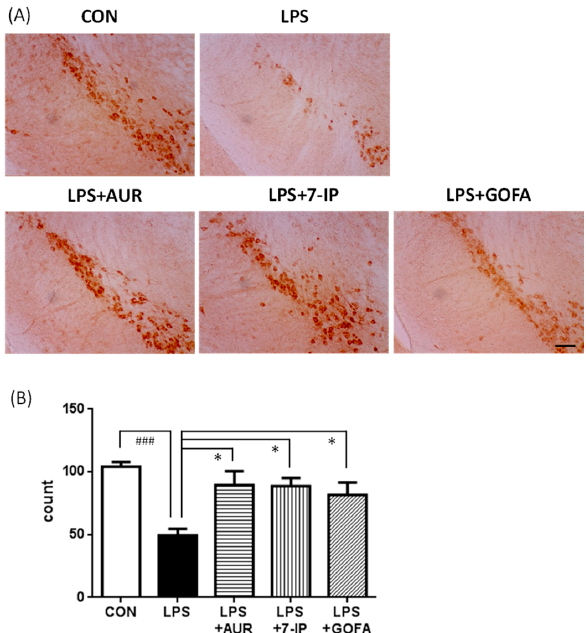
Figure 5. Effects of AUR, 7-IP, and GOFA on LPS-induced neuronal cell loss in the substantia nigra. ( A ) Representative micrographs of tyrosine hydroxylase (TH)-positive neuronal cells on day 22 in the indicated groups. Scale bar = 100 μ m; ( B ) Total intact cell number of TH-positive neuronal cells. Values are the means ± SEM. Significant differences were observed between CON and LPS ( ### p < 0.001) and between LPS and sample treatment groups (* p < 0.05).